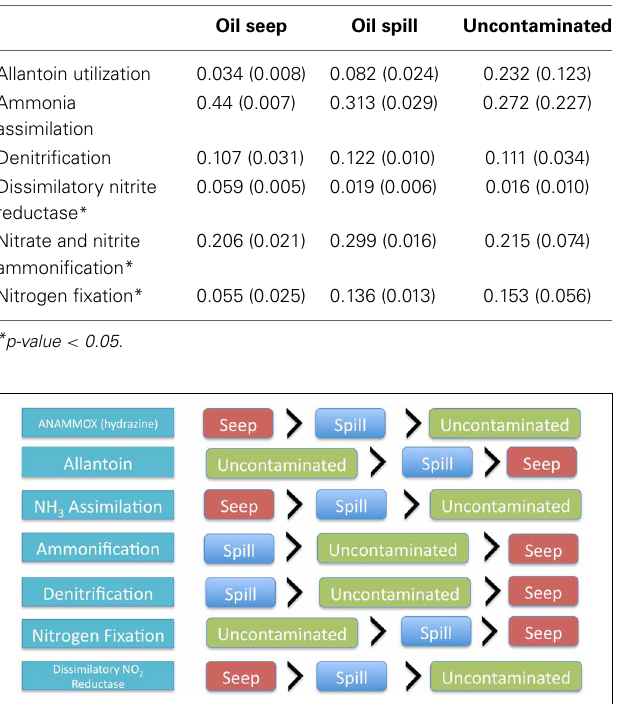
Table 1 | Average proportion of reads annotation to each SEED subsystems-based functional annotation (level 2) function from nitrogen metabolism with their standard deviations in parentheses.